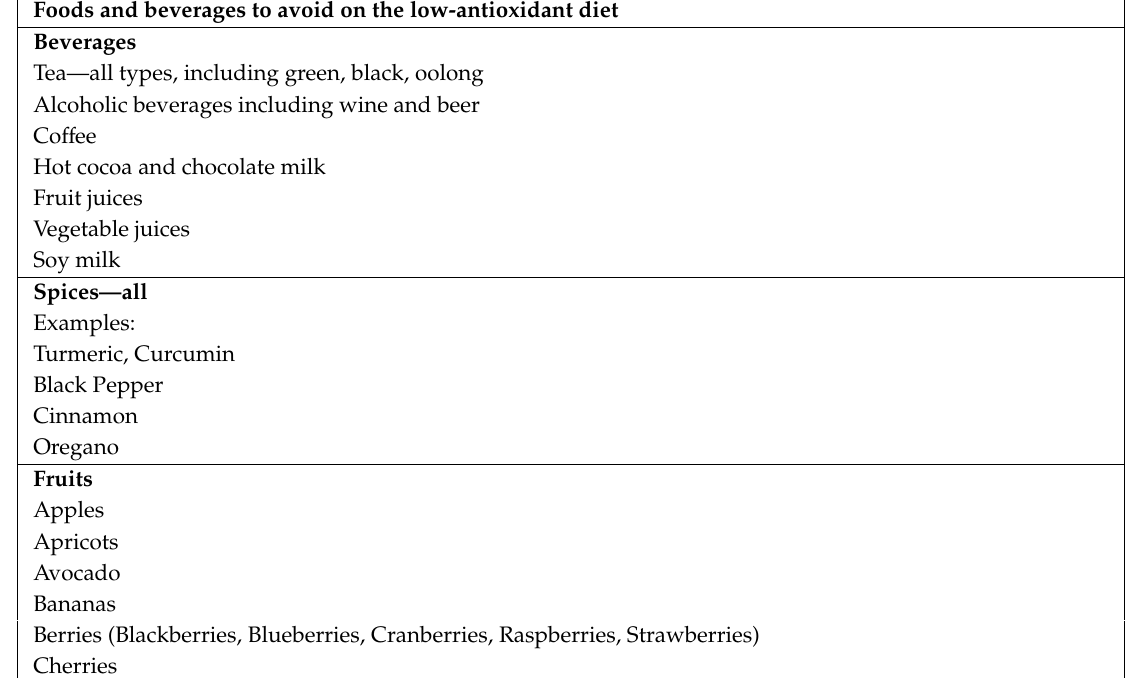
Beverages Tea—all types, including green, black, oolong Alcoholic beverages including wine and beer Co ff ee Hot cocoa and chocolate milk Fruit juices Vegetable juices Soy milk Spices—all Examples: Turmeric, Curcumin Black Pepper Cinnamon Oregano Fruits Apples Apricots Avocado Bananas Berries (Blackberries, Blueberries, Cranberries, Raspberries, Strawberries) Cherries Dates Figs Kiwi Red, purple, black grapes Prunes Raisins Citrus fruits (grapefruit, orange) Mango Peaches (raw) Pears (raw) Plums Vegetables Artichokes Asparagus Beans (small red, pinto, kidney, black) Beets Bell peppers (red, green, yellow, orange) Broccoli Cabbage Eggplant (raw) Green leafy vegetables (romaine, spinach, kale, collard greens) Onions Russet or red potato Sweet potatoes Tomatoes-all fresh and processed products (tomato sauce or paste, tomato juice, spaghetti sauce, pizza sauce, salsa